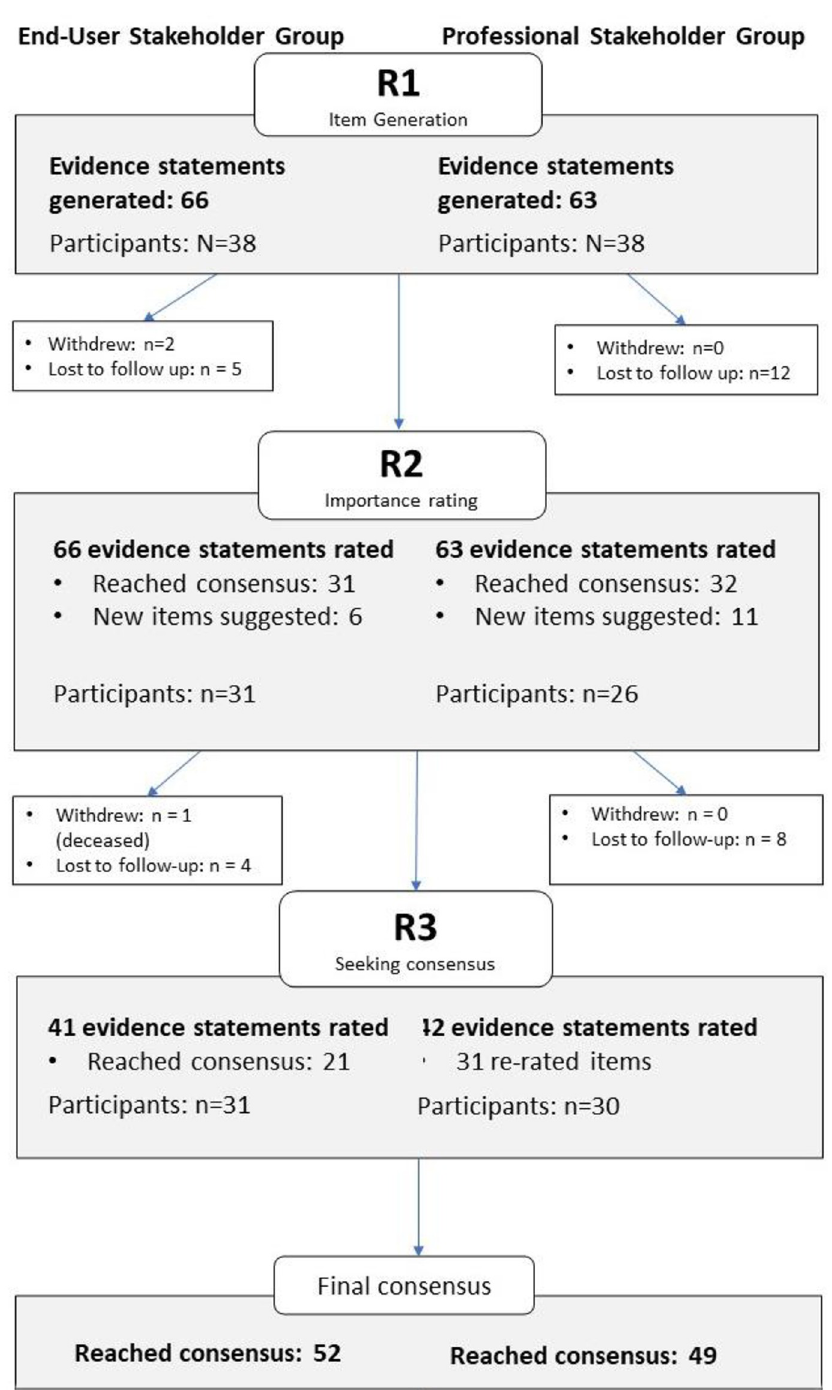
Fig 3. Participant and data item